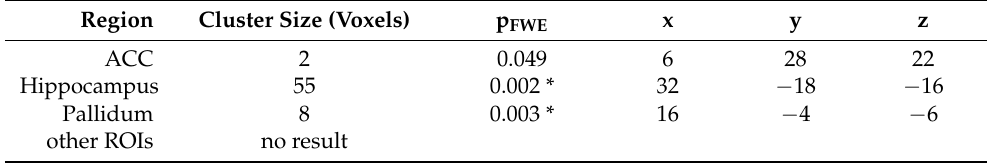
Table 5. Group differences in activation by ExecAttent in healthy controls (HC) and patients with RRMS. Results of permutation tests using threshold-free cluster enhancement. Clusters containing only voxels with pFWE < 0.05 and their maximum with MNI coordinates are shown. Bonferroni threshold is pB = 0.05/6 = 0.008 considering tests for six ROIs. p -values ≤ pB are marked with an asterix. All tests indicate higher activation in HC than in